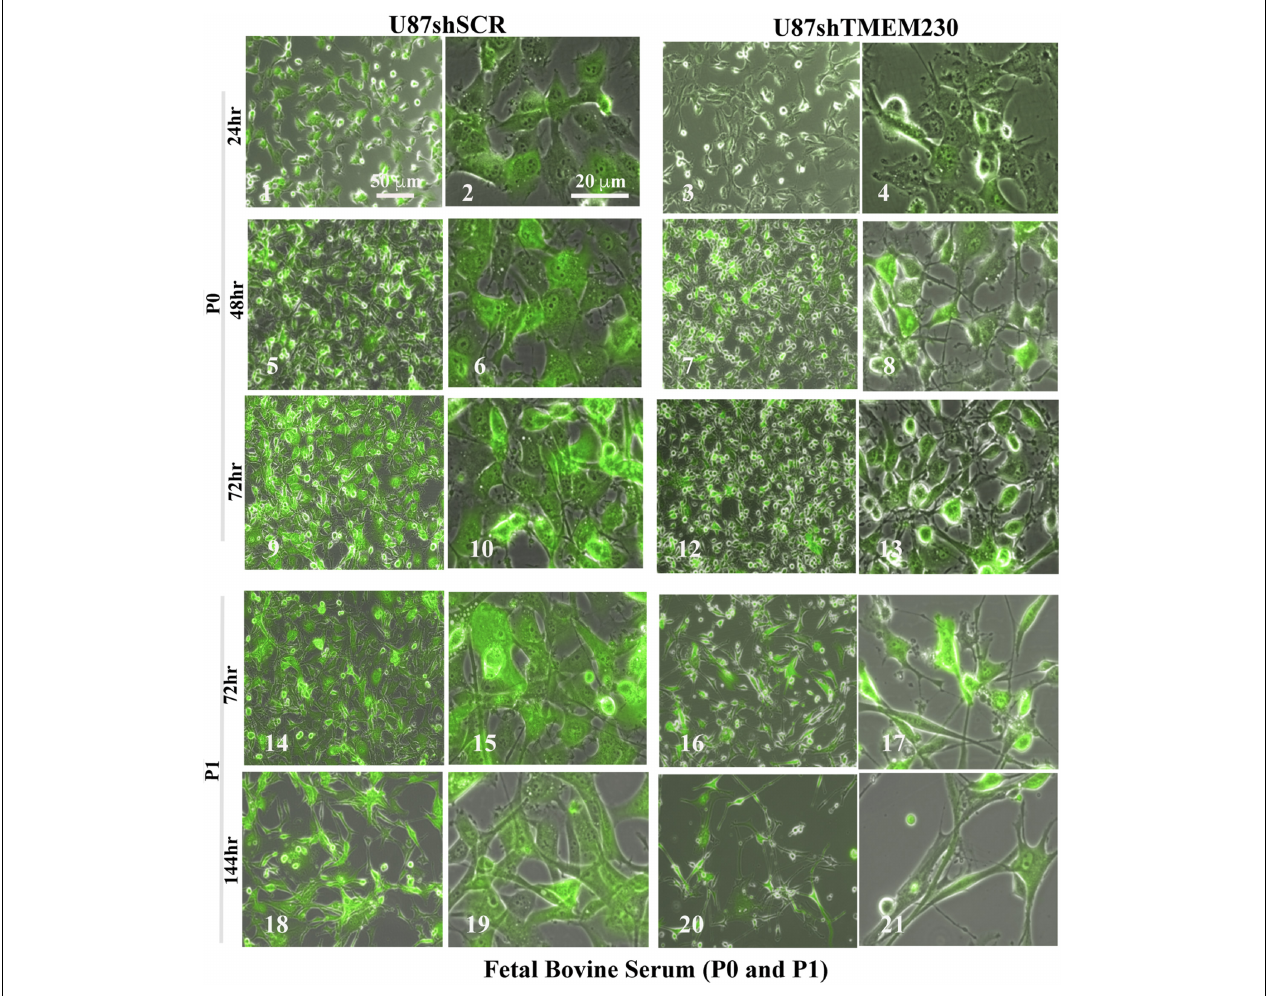
FIGURE 3 | Downregulation of TMEM230 was sufficient to promote loss of U87-MG substratum adhesion capacity in fetal bovine serum containing media. Control (U87shSCR) and U87 cells in which TMEM230 was constitutively downregulated (U87shTMEM230) were cultured in extracellular vesicle depleted FBS (Fetal Bovine Serum) containing culture media. Equal number of control cells and cells in which endogenous TMEM230 was downregulated were plated (P0) in vesicle depleted FBS containing culture media and monitored over 72 h, starting from when green fluorescent protein (GFP) expression was first observed (0 h, not shown). Cells in which TMEM230 were downregulated displayed decrease in cytoplasm dimensions and disrupted cytoplasmic invadopodium like extensions. Cells were re-passaged (P1) and monitored for additional 144 h. Re-passaged cells (P1) displayed a more limited capacity for cell adhesion, supporting that TMEM230 is necessary for scaffold attachment of cells.